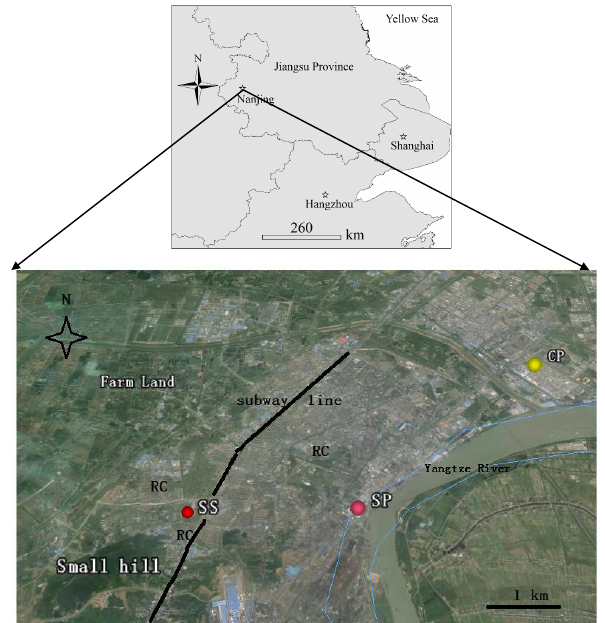
Figure 1. Location of the sampling site (the red dot, SS). SP: iron smelt plant; CP: chemical industrial park; RC: residential commu- nity. The black line indicates the subway line near